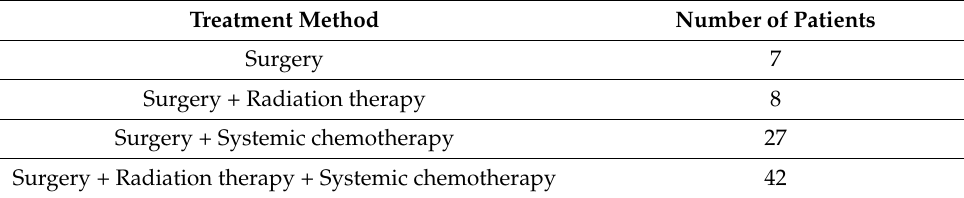
Table 1. The number of patients with various methods of BC